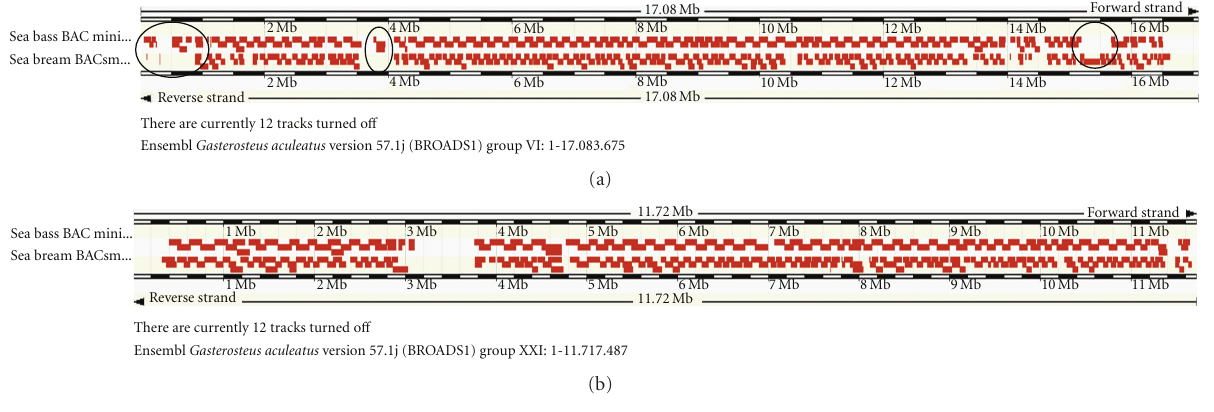
Figure 3: Mapped minimal tiling path BAC clones of sea bream and seabass alongside the stickleback chromosomes VI (a) and XXI (b). While maps in (a) show some di ff erences in regions covered or not covered (marked with black circles), maps in (b) are nearly